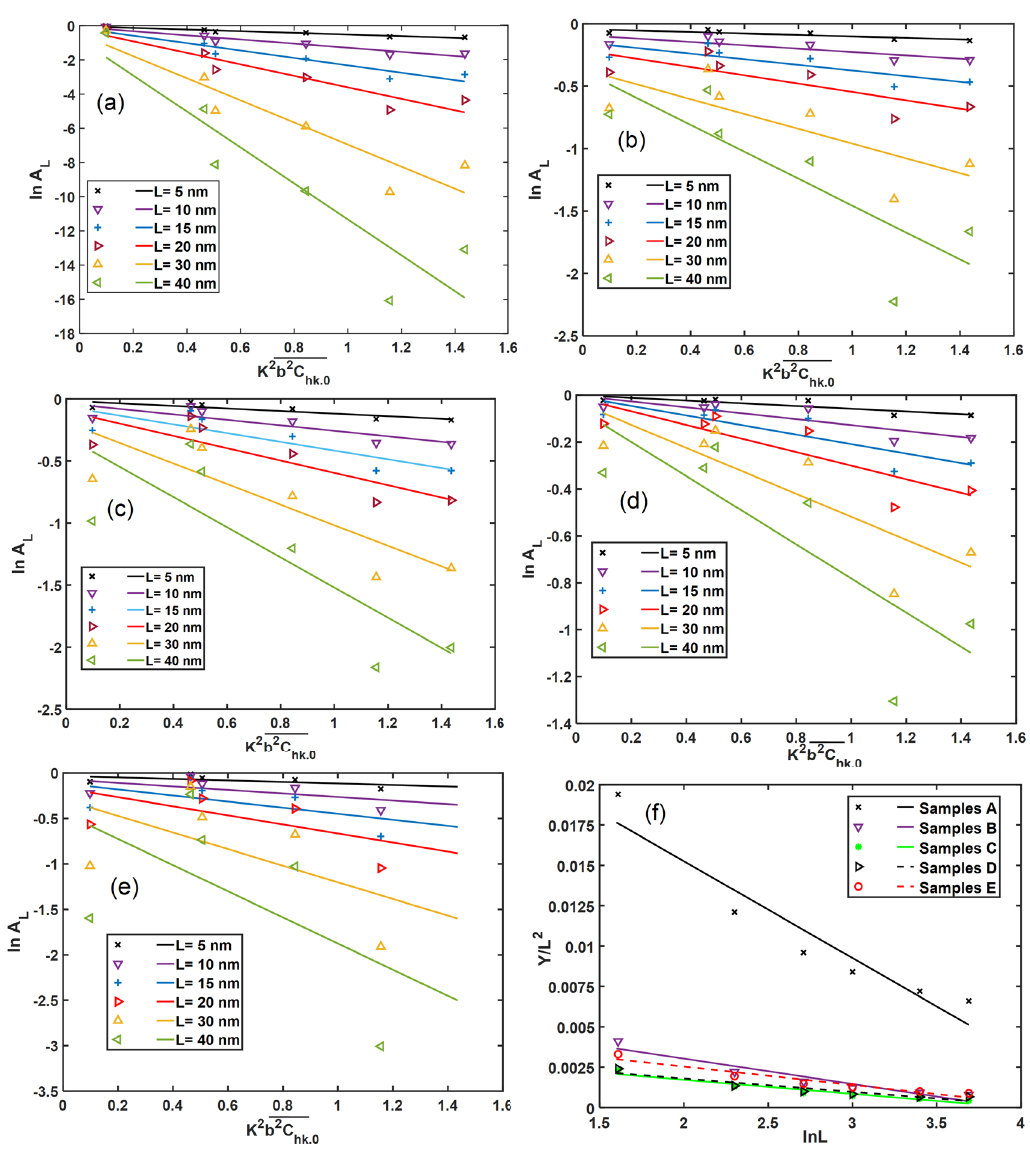
Figure 12. The modified Warren–Averbach plot of DMLS Ti6Al4V (ELI) samples types ( a ) A, ( b ) B, ( c ) C, ( d ) D and ( e ) E according to Equation (7), while ( f ) is a plot according to Equation (8).